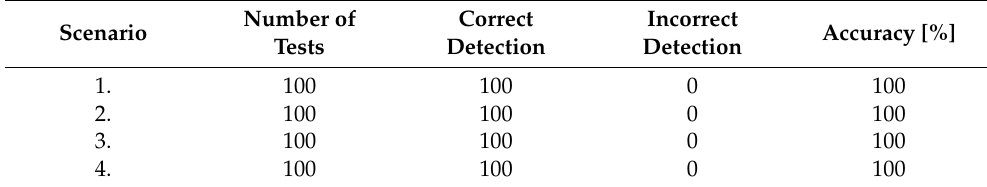
Table 2. Gate node implementation testing results.